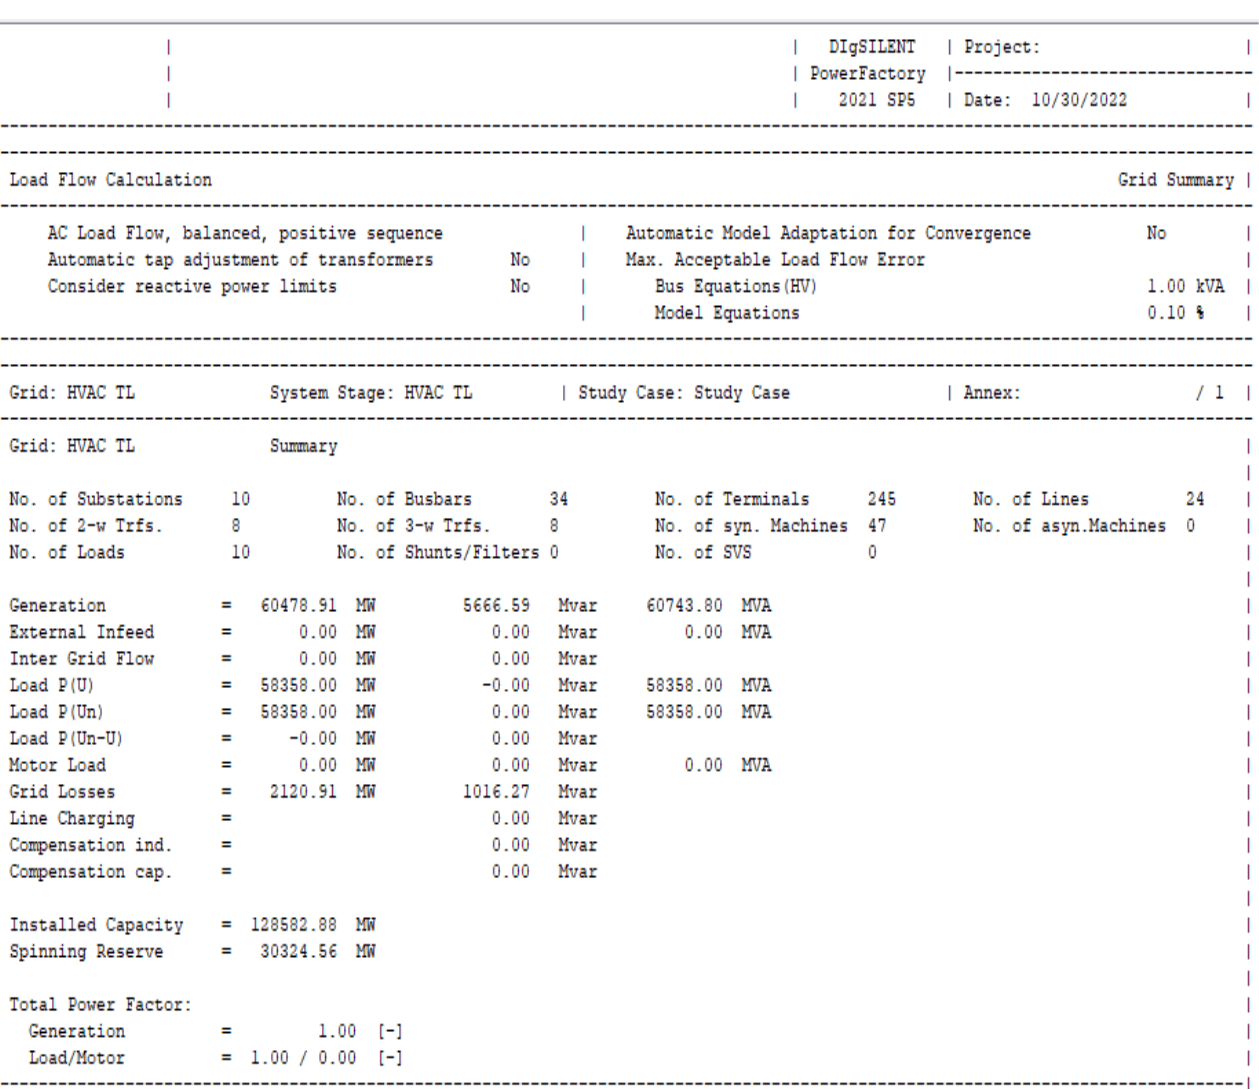
Figure A2. Southern African Regional grid network model with base case summary of HVAC with an HVDC link load flow analysis shows the losses incurred as a result of the LCC-HVDC link im- pact.